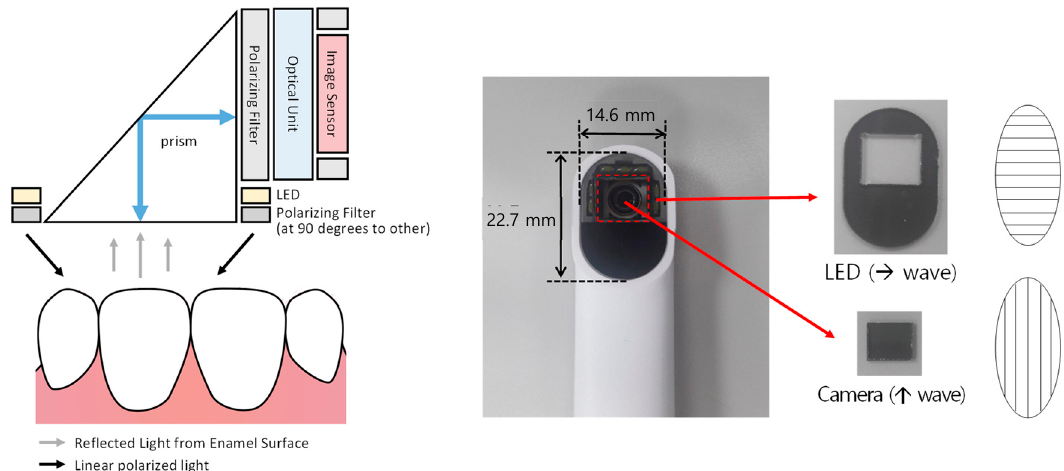
Figure 1. Schematic of the developed digital shade-matching device for dental color determination. LED, light-emitting diode.